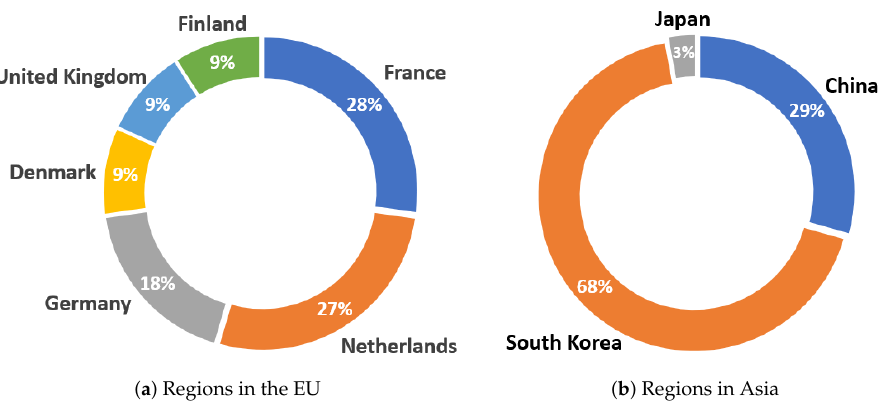
Figure 7. Country distribution for the commercial wearables developed in Europe ( a ) and Asia ( b